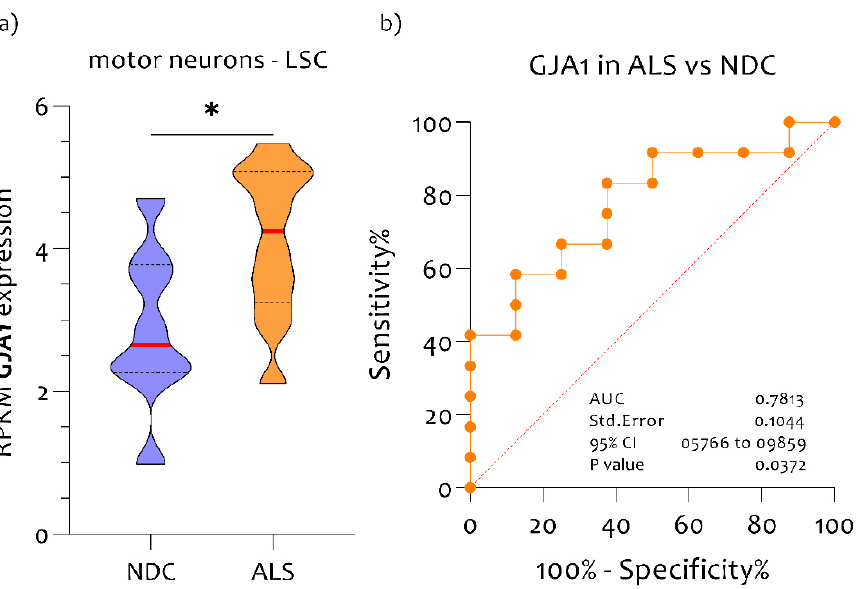
Figure 1. GJA1 is highly expressed in the spinal cord and MNs of ALS patients compared to NDC. ( a ) GJA1 expression levels in MNs of NDC (n = 9) and ALS (n = 13); ( b ) perfect diagnostic ability of GJA1 expression levels to discriminate NDC subjects from ALS patients (AUC = 0.7813, p < 0.037). Data are expressed as RPKM intensity expression levels (means and SD) and presented as violin dot plots. * p -value < 0.01. Table 3. Neuro-immune cells